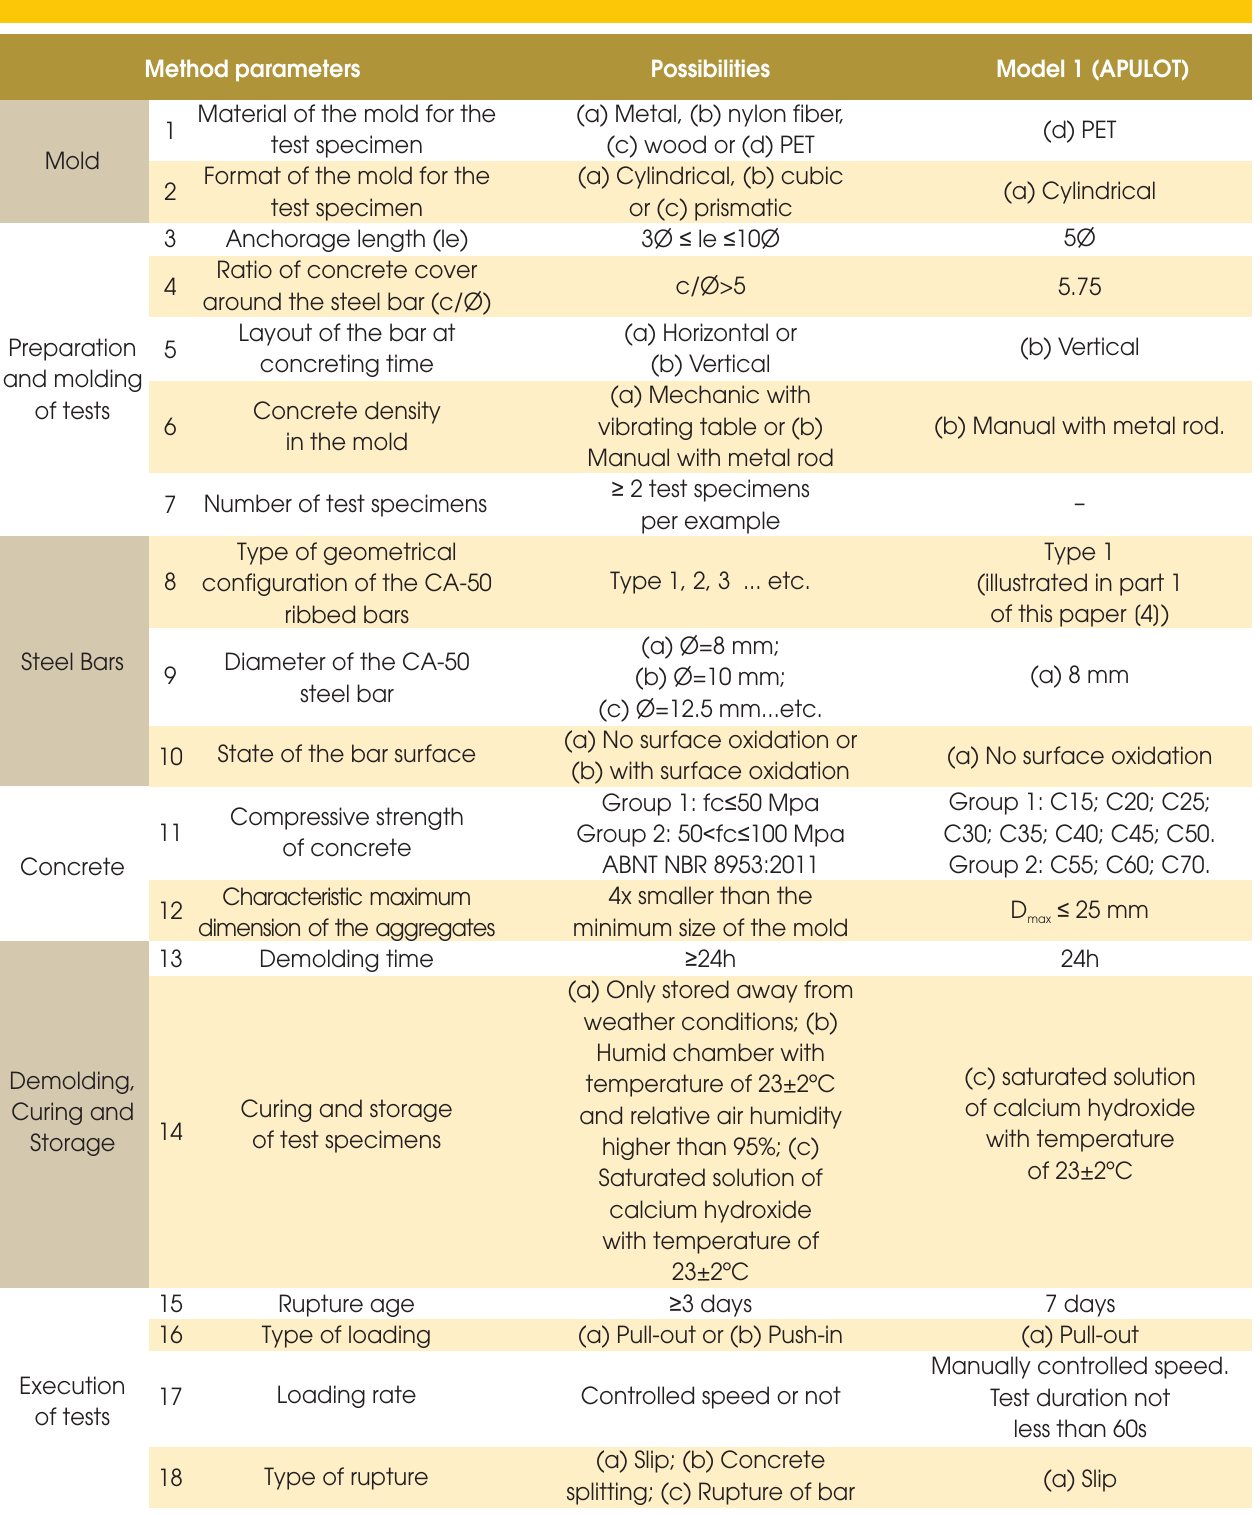
Table 4 – Parameters for the standardization of the test method in the